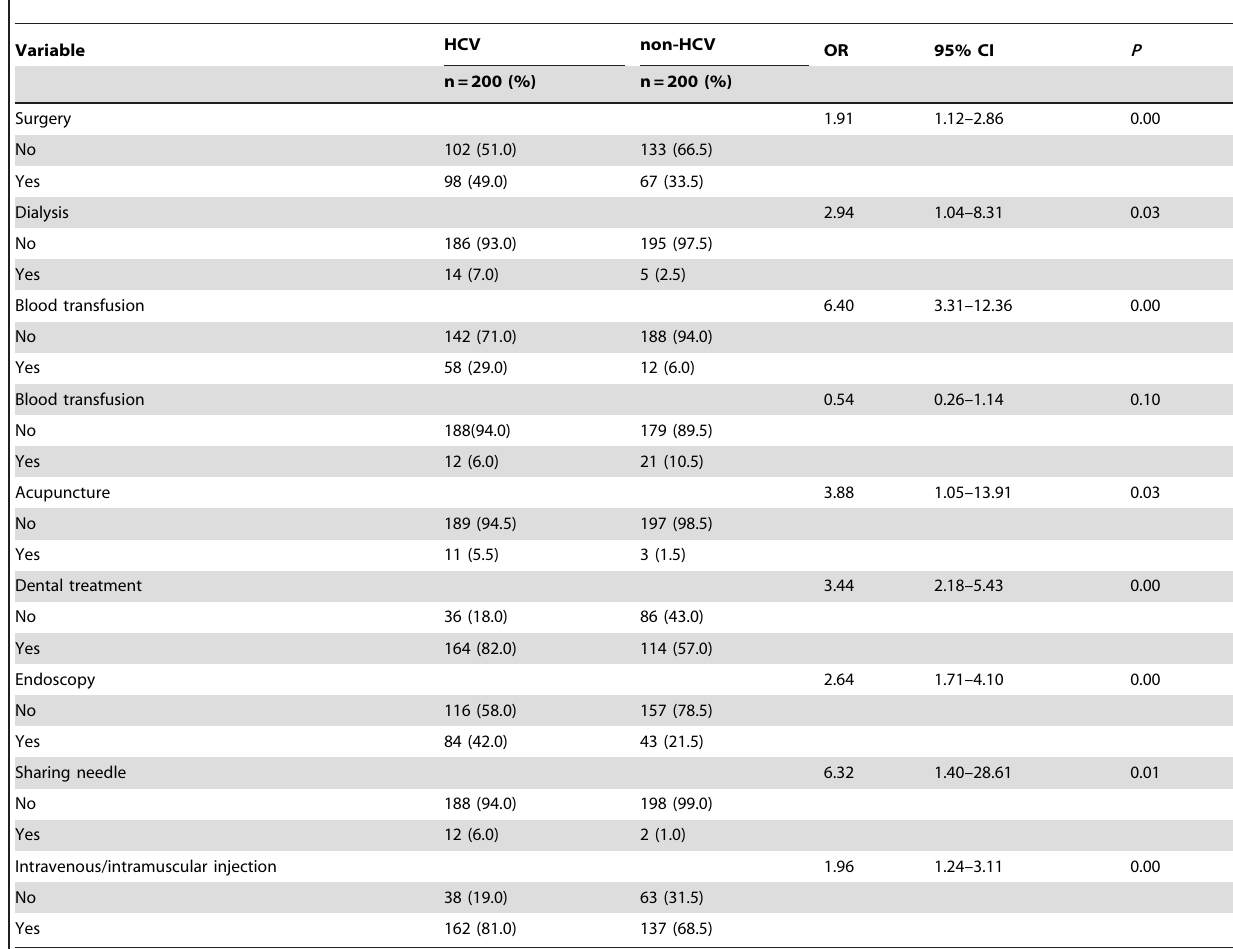
Table 1. Risk factors related to medical behaviour among HCV and non-HCV